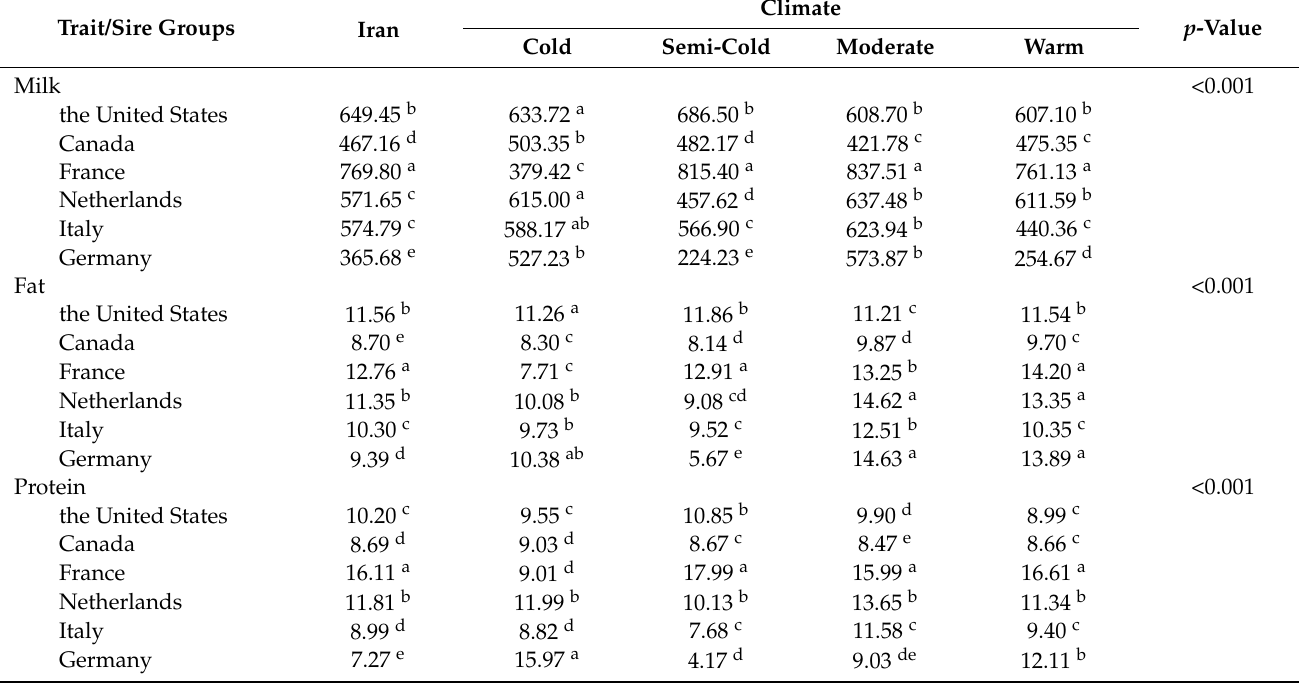
Table 3. Comparison of estimated breeding values (EBVs) for production traits between daughters from different sire groups in Iran and its various climates